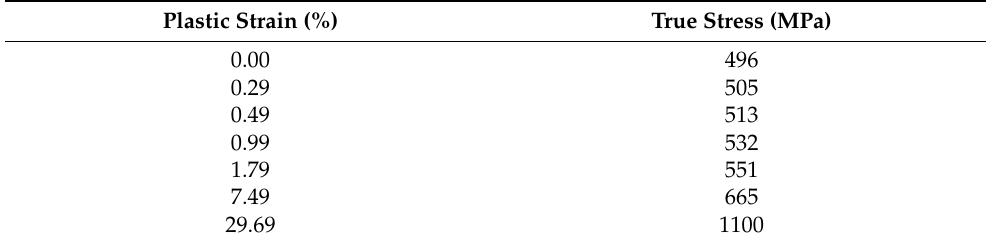
Table 5. Plastic strain and stress used on the numerical